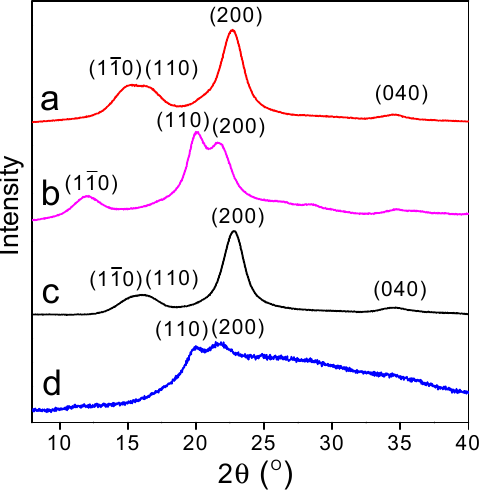
Figure 3. X-ray diffraction curves of (a) pristine cellulose; (b) NaOH/urea-treated cellulose; (c) direct TEMPO-oxidized cellulose; and (d) NaOH/urea-treated TEMPO-oxidized cellulose.